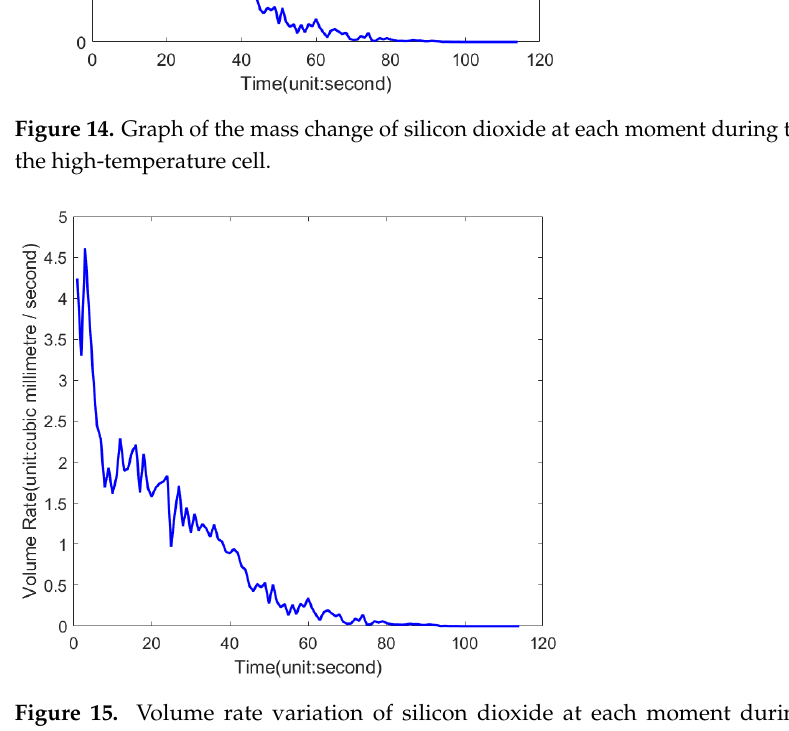
Figure 14. Graph of the mass change of silicon dioxide at each moment during the melting process in the high-temperature cell.